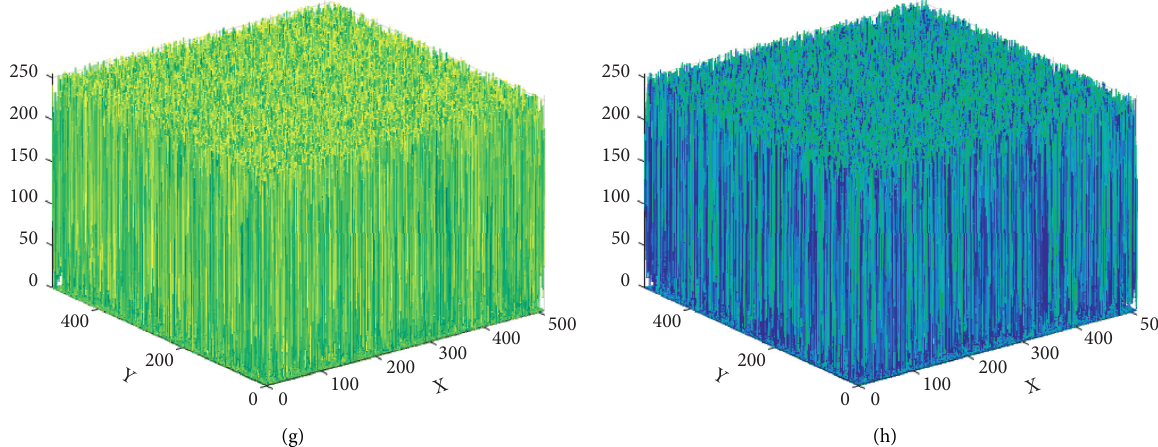
Figure 5: (a–d) 3D histogram of brain original image layers; (e–h) 3D histograms of brain encrypted image layers, respectively.